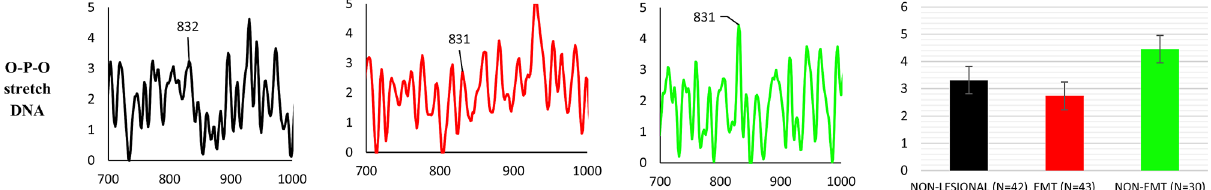
Figure 8. Summary of nucleic acid vibrational bands observed for dewaxed samples (Group 1) in non-lesional, EMT and non-EMT breast cancer tissue. For each case, the x-axis represents the wavenumber while the y-axis represents the intensity. The colour black represents the non-lesional tissues, while red represents EMT tissues and green represents non-EMT tissues. Comparison of the relative intensity of nucleic acid Raman bands for dewaxed samples in non-lesional, EMT and non-EMT breast cancer tissue is depicted in the bar chart. Each column represents the average of spectra for each type of tissue. The value of N represents the number of Raman spectra acquired for each sample, shown within the brackets. The error bar represents standard deviation. Note: the x-axis represents the tissue type and y-axis is Raman intensity. No statistically significant differences between the groups are reported by the ANOVA